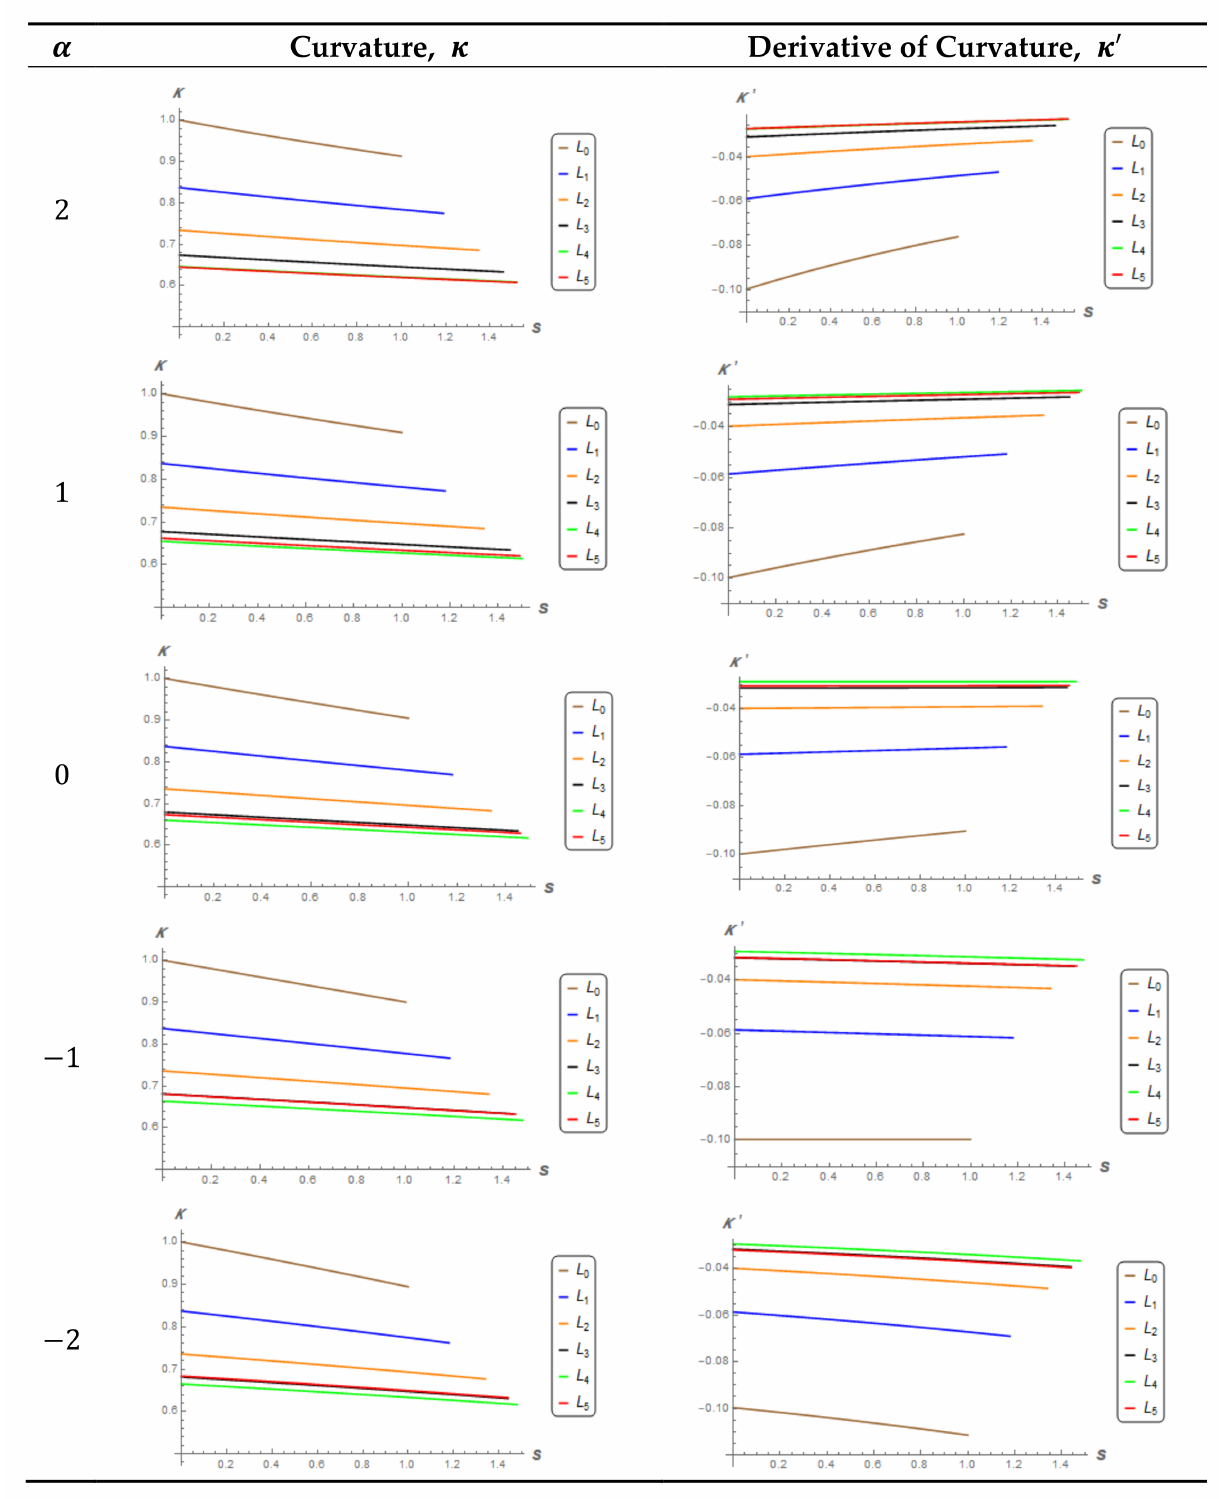
Figure 7. Curvature and its derivative of curvature for maximum principal direction LoCs ( L 0 to L 5 ) on LA swept